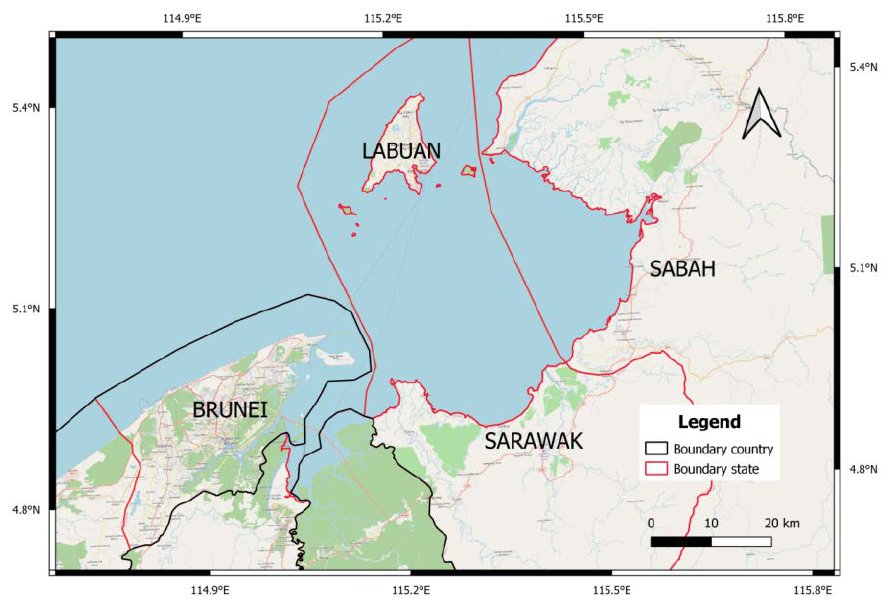
Figure 1. The map of the Bay of Brunei is shared among four Federal Territory of Labuan, Sabah and Sarawak and Brunei Darussalam.